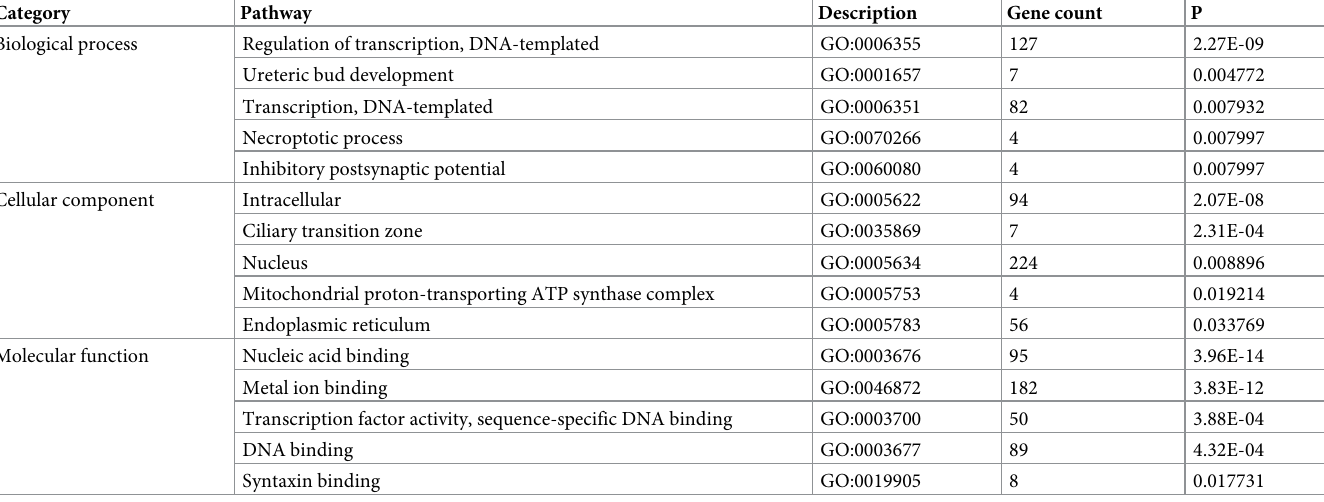
Runx2 and Bglap to decline. The qRT-PCR showed that Clock mRNA was upregulated in BMSCs under osteogenic induction (Fig 4F). To illustrate the expression of CLOCK protein in vivo , mice were infused with 2 μ g N.g MDP dissolved in 100 μ l of saline solution once a day for Table 3. The significantly enriched pathways associated with 724 mRNAs in the N.g MDP–treated osteocyte model.